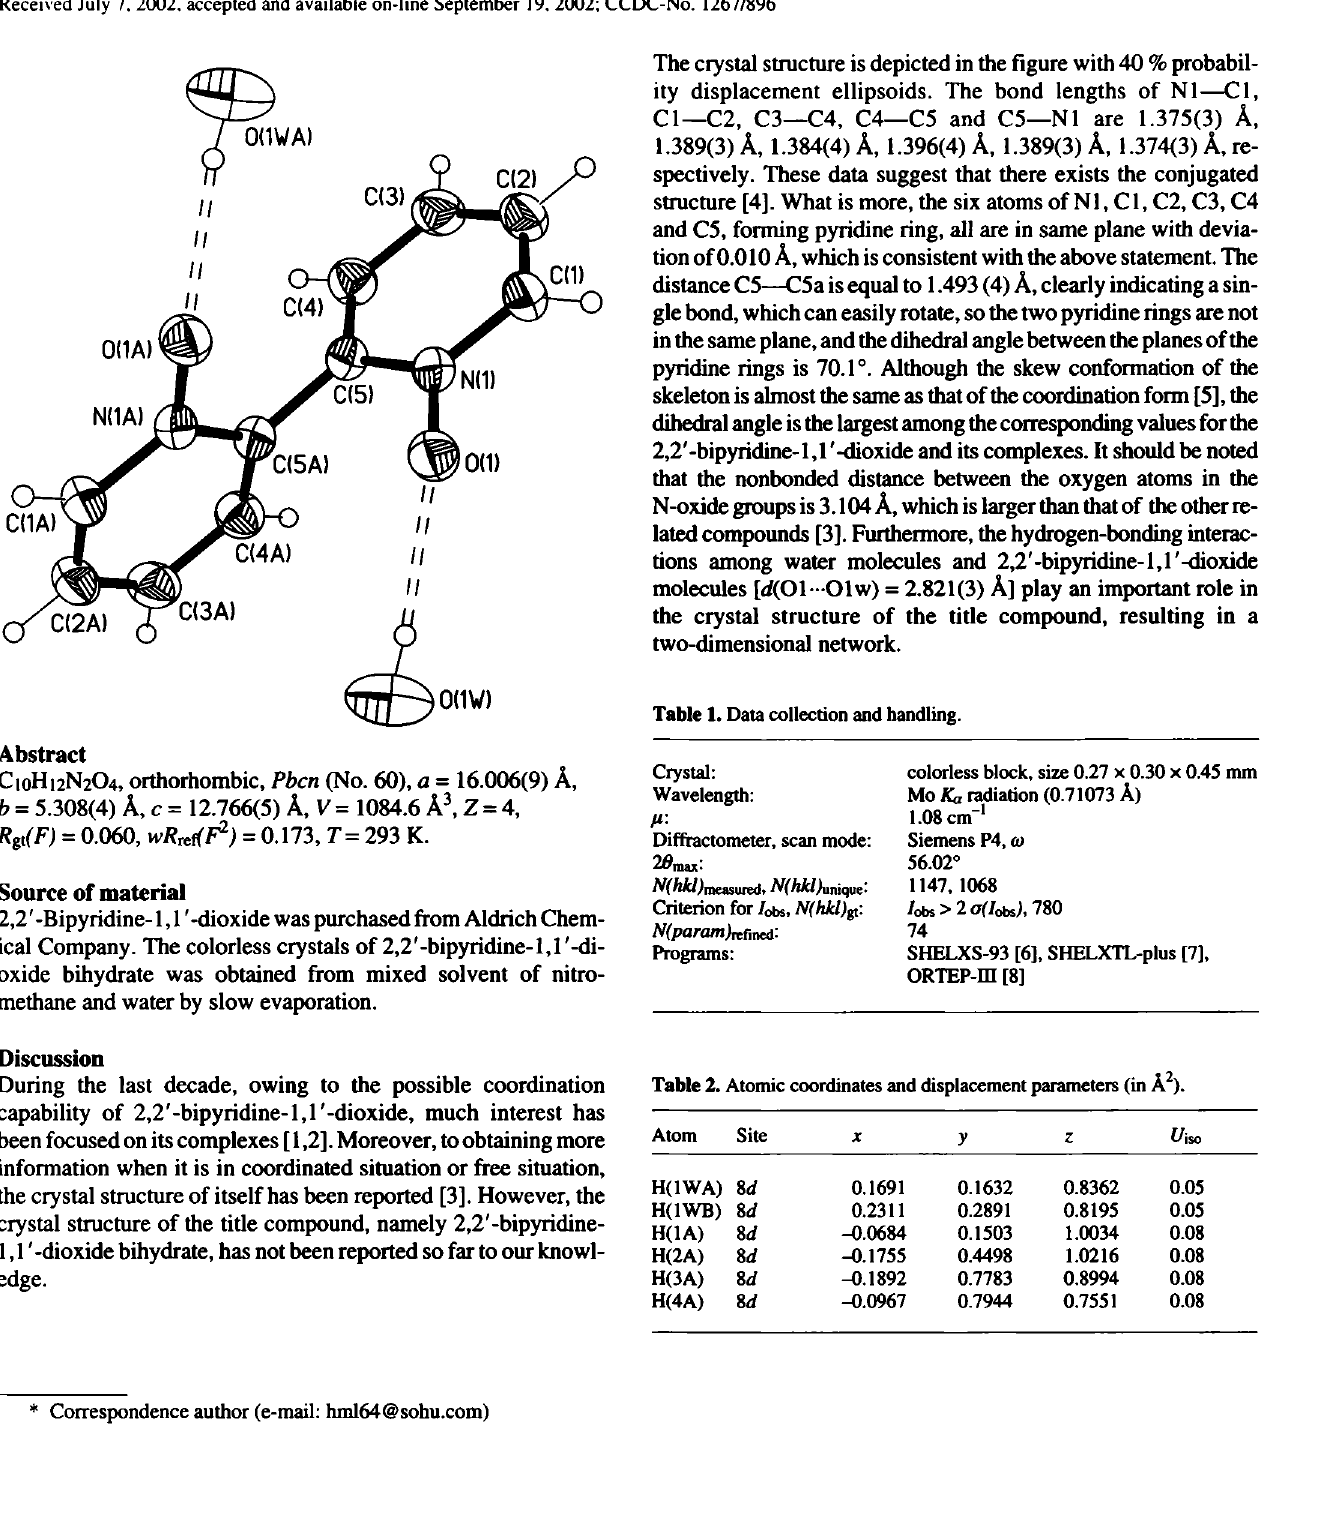
Table 2. Atomic coordinates and displacement parameters (in Â 2